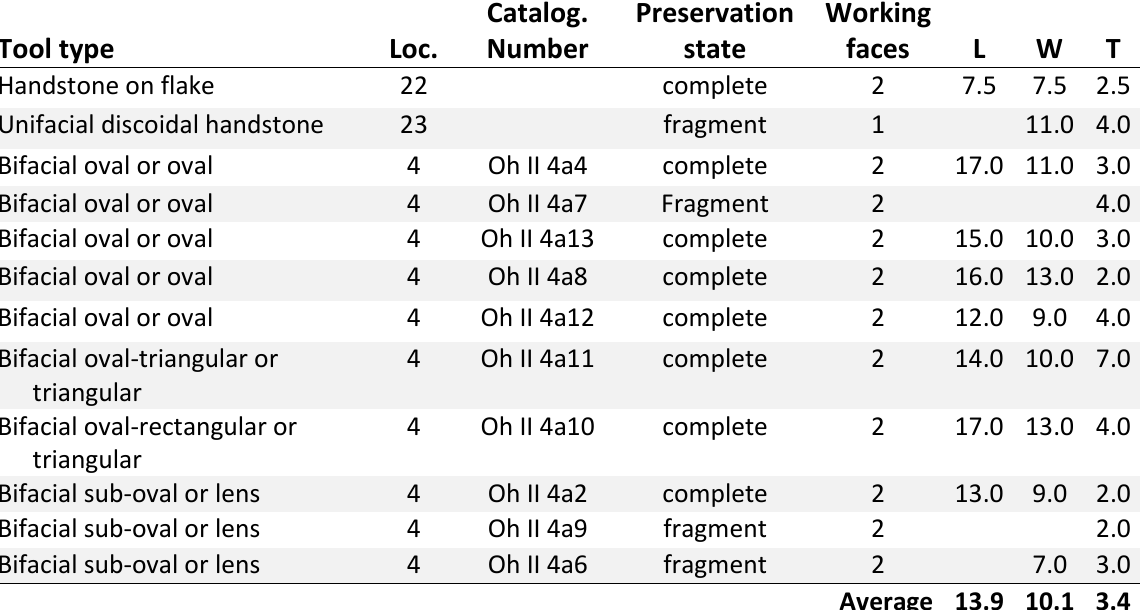
Table 3. Data and dimensions of 12 handstones. Abbreviations: STD - standard deviation; L - length; W - width; T -